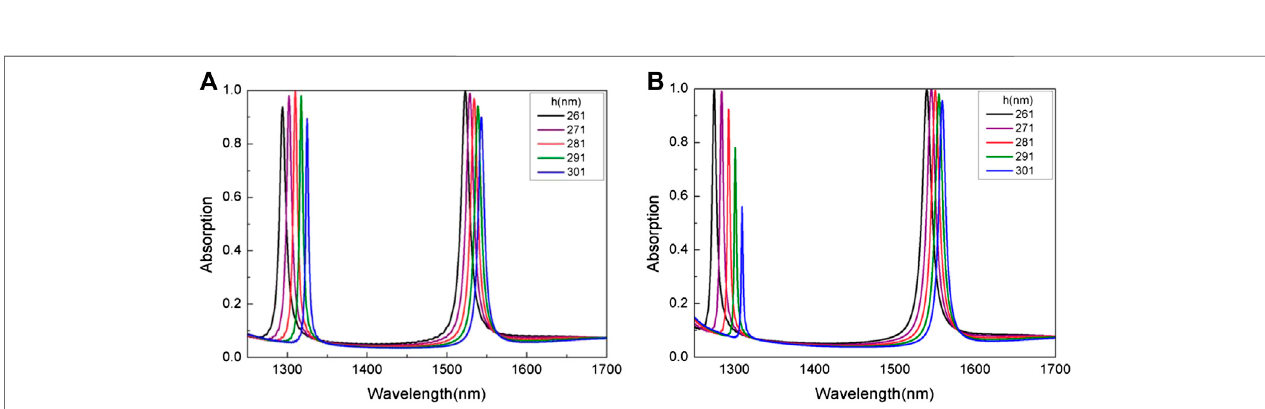
FIGURE5| Absorptionspectrum forthesiliconlayerhwithdifferentthicknesses at (A) 1310 nm and (B) 1550 nm.Otherstructuralparameters areconsistent with those in Figure 1 .